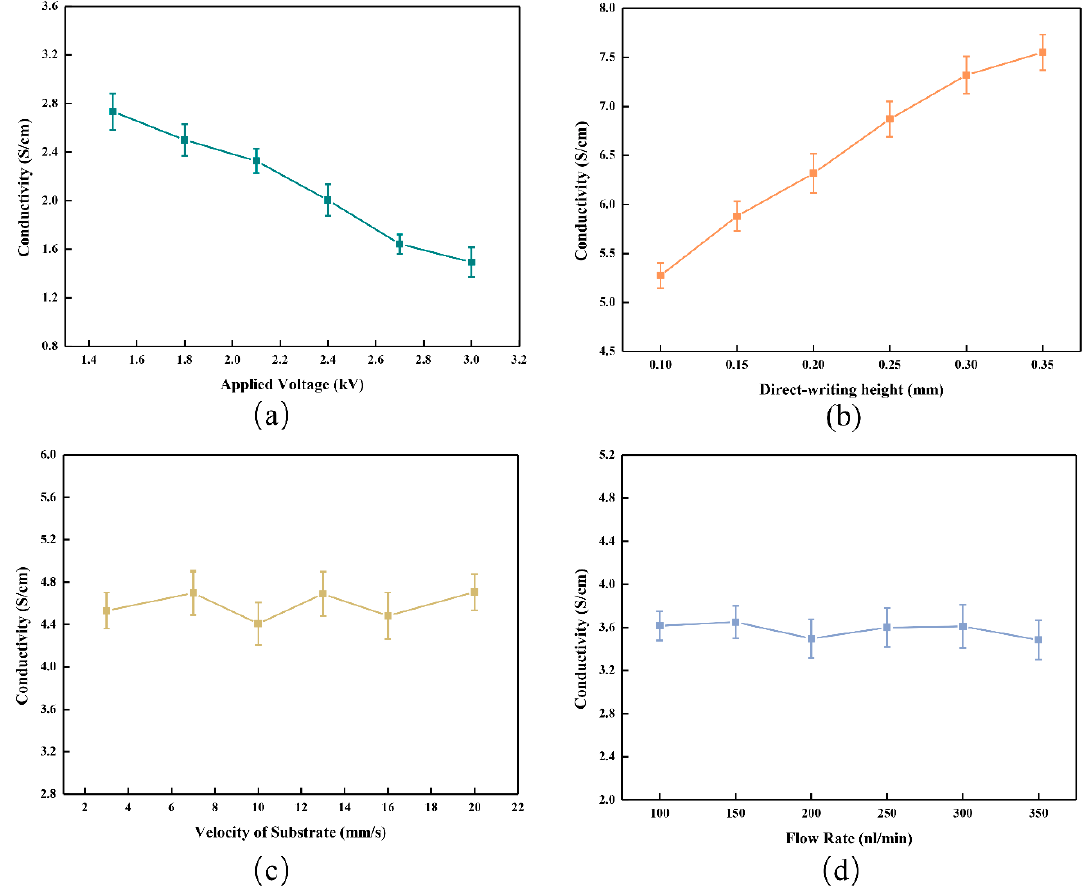
Figure 9. Effect of different process parameters on the electrical conductivity. ( a ) An applied voltage from 1.5 to 3.0 kV, direct-writing height of 0.35 mm, moving velocity of 10 mm/s, and flow rate of 80 nL/min. ( b ) A direct-writing height from 0.1 to 0.35 mm, applied voltage of 2.0 kV, moving velocity of 5 mm/s, and flow rate of 166 nL/min. ( c ) A moving velocity from 3 to 20 mm/s, applied voltage of 2.0 kV, direct-writing height of 0.4 mm, and flow rate of 166 nL/min. ( d ) A flow rate from 100 to 350 nL/min, applied voltage of 2.0 kV, direct-writing height of 0.15 mm, and moving velocity of 10 mm/s.